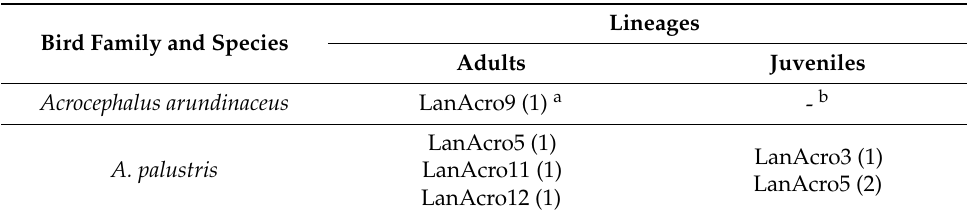
Table 3. Lankesterella lineages found in adult Passeriformes birds and juveniles of the